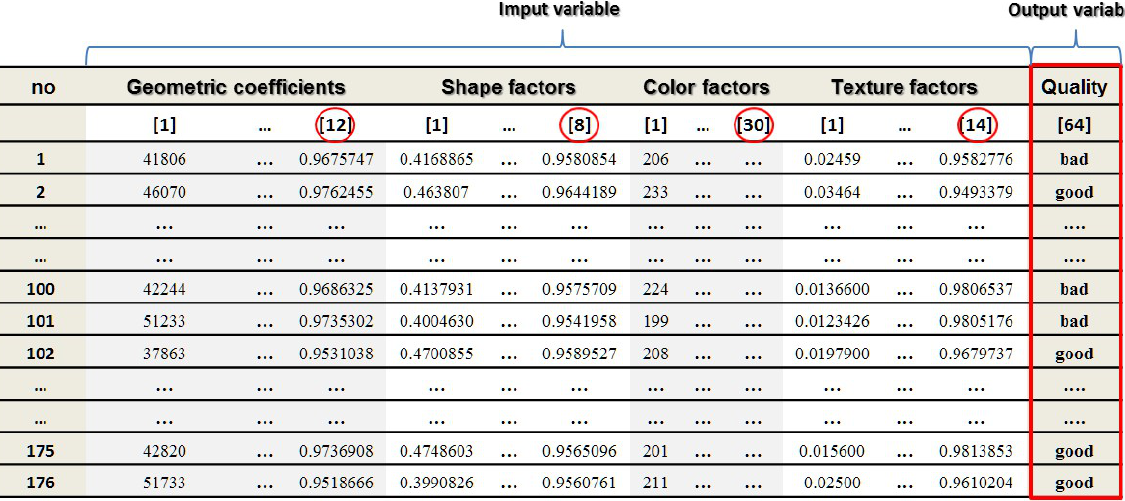
Figure 6. The structure of the training file.